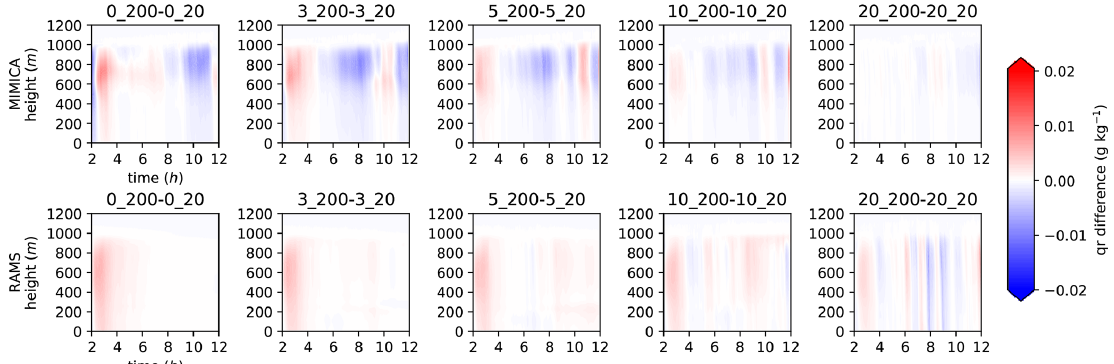
Figure 8. Differences in rain mixing ratio (qr) for simulation pairs with the same accumulation mode concentration (i.e. ACx_AK200– ACx_AK20) shown for MIMICA and RAMS. The first 2h of simulations, considered as the spin-up period, are excluded. A Student’s t test with a 95% confidence level shows that the (time mean) differences are statistically significantly different for each pair of simulations, except for the pair AC20_AK200 and AC20_AK20 in MIMICA. For figure clarity, the plot titles have been abbreviated; the first number refers to the accumulation mode and the second to the Aitken mode concentration in cubic centimetres, i.e. 0_20 refers to